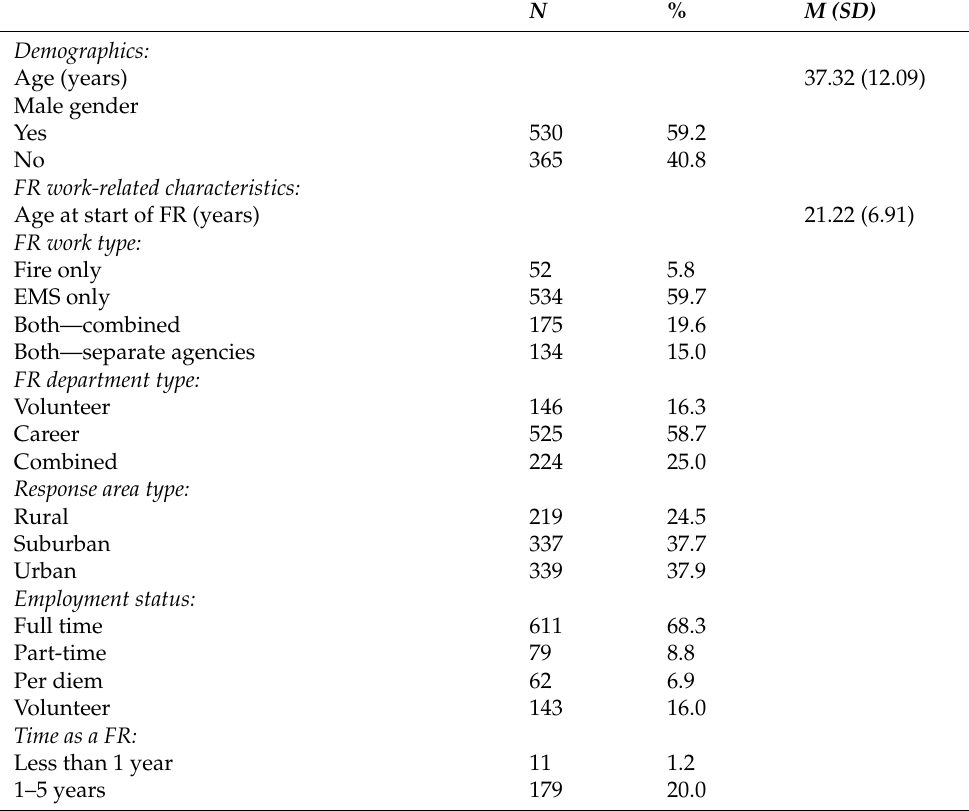
Table 1. Participant demographics and work-related covariates ( N =